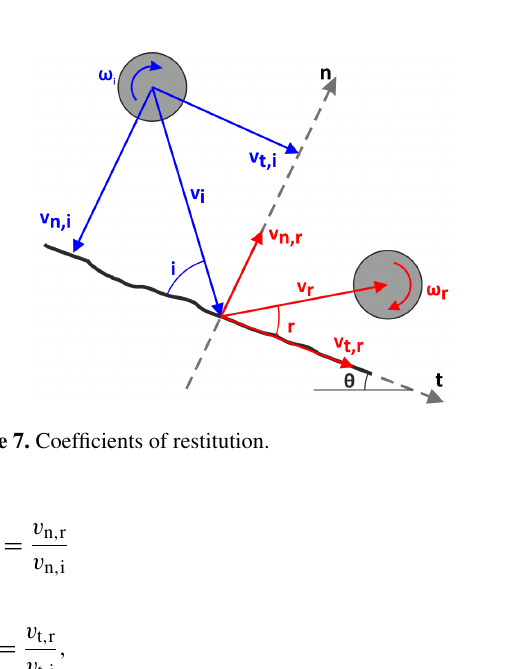
Figure 6. Acceleration time history recording at the Vasiliki site (ITSAK, 2016).